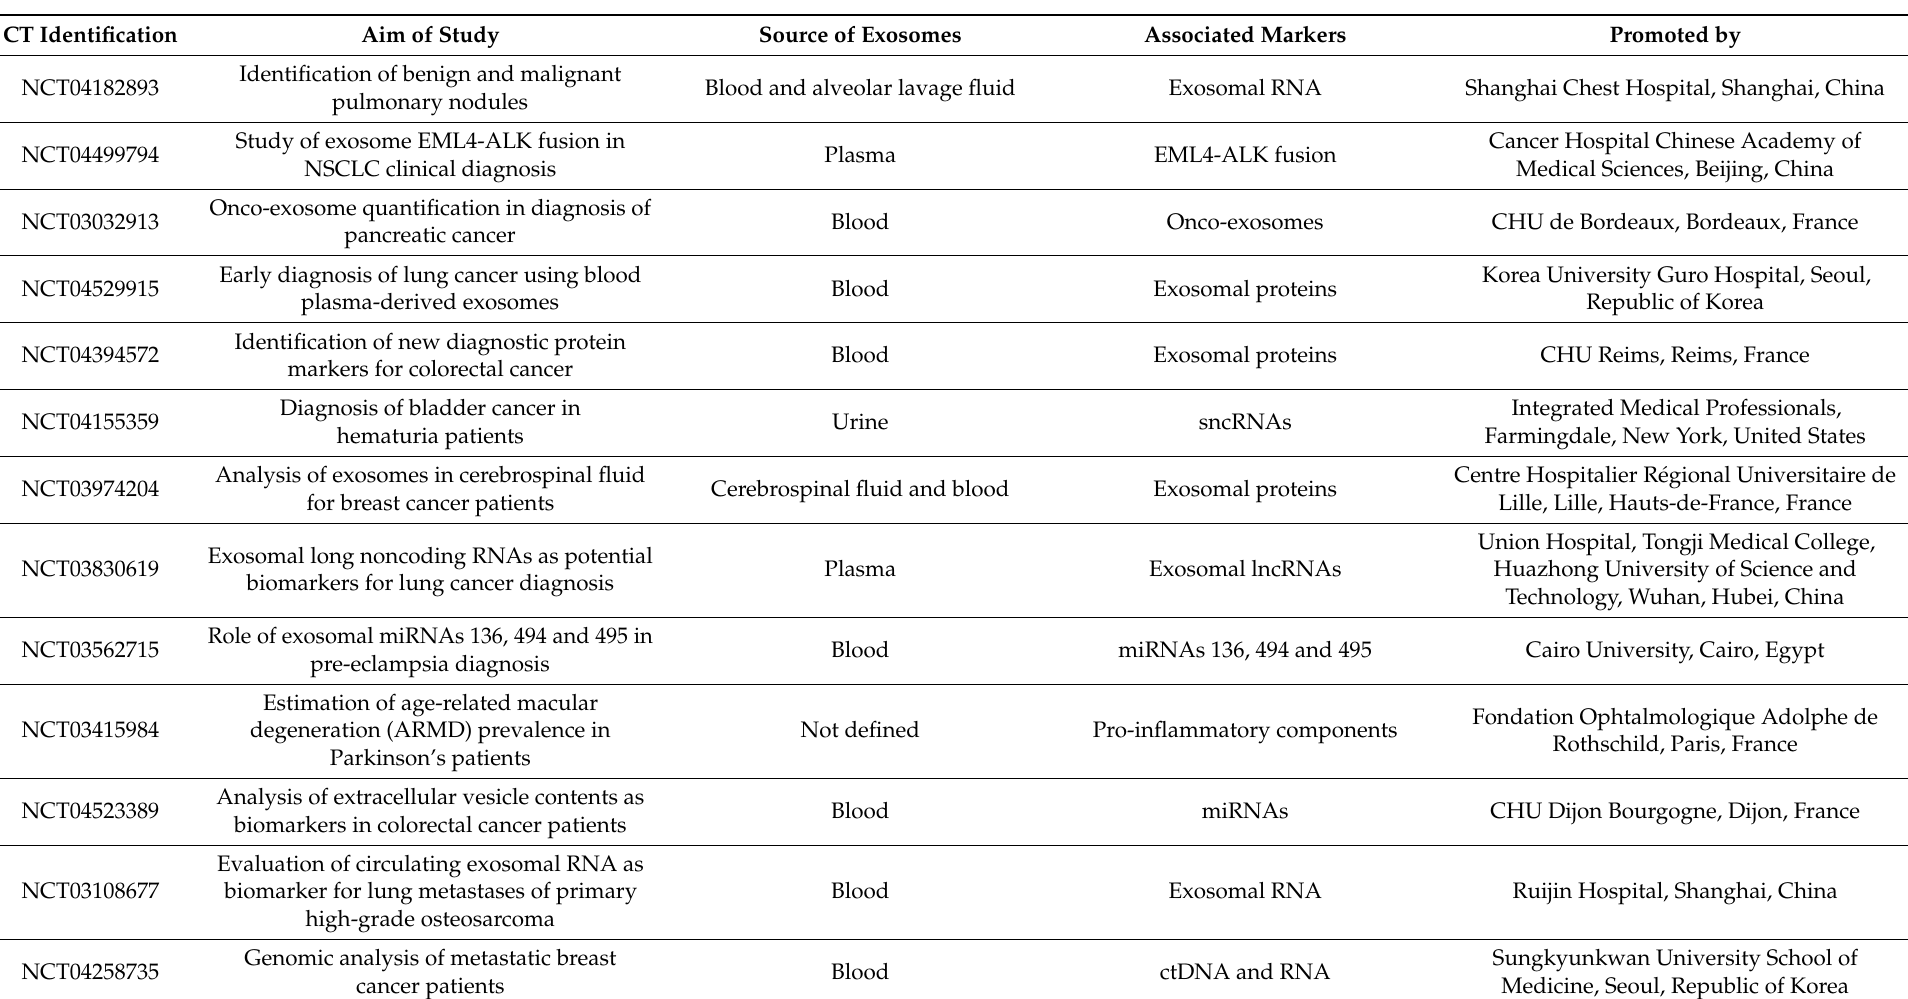
Table 2. Representative table showing a selection of concluded and ongoing clinical trials (Clinical trial.gov; November 2020) utilizing exosomes as biomarkers mainly for cancer diagnosis and, to a lesser extent, for the early detection of other diseases. The clinical work involving the diagnostic application of exosomes has not yet been published or made available for peer